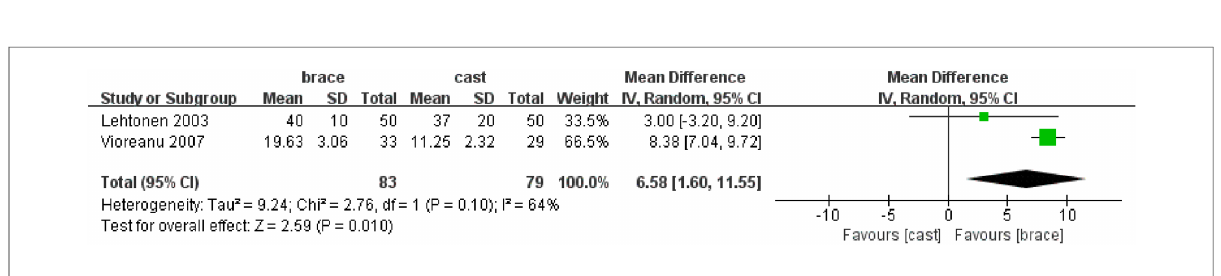
FIGURE 7 Forest plot of comparing cast versus brace groups for the ankle plantar fl exion in 6w. CI, con fi dence